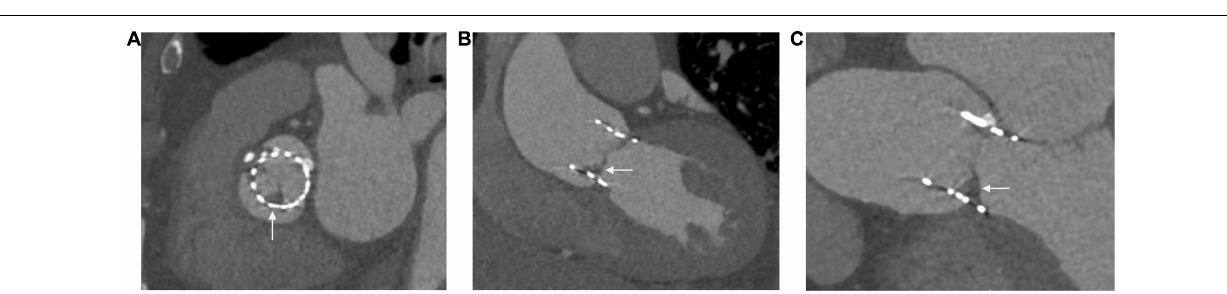
FIGURE 4 | Hypo-attenuated leaflet thickening seen in three views of the same patient (A) at the level of the sinus of Valsalva, (B) left ventricular outflow tract view, (C) three chamber